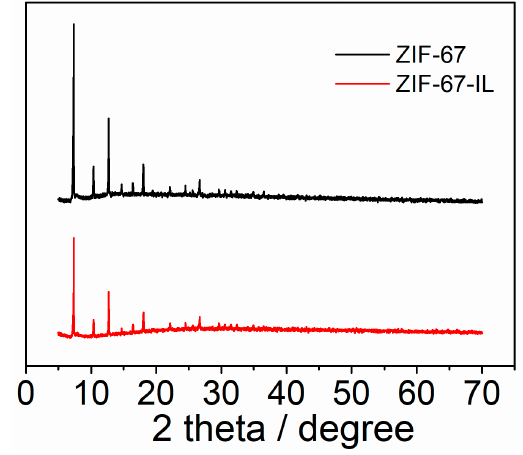
Figure 3. X-ray di ff raction (XRD) patterns of ZIF-67 and